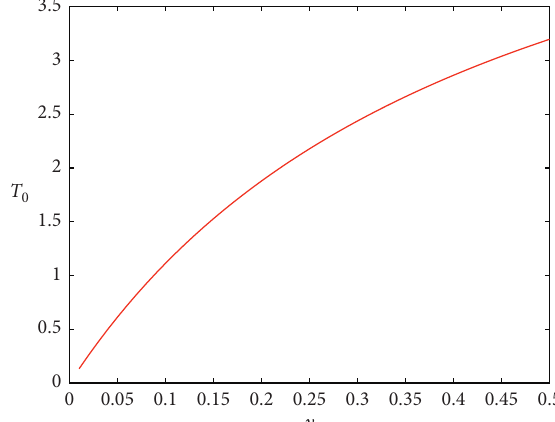
Figure 6: T 0 versus β in the case where μ � 1, and C W � 1.